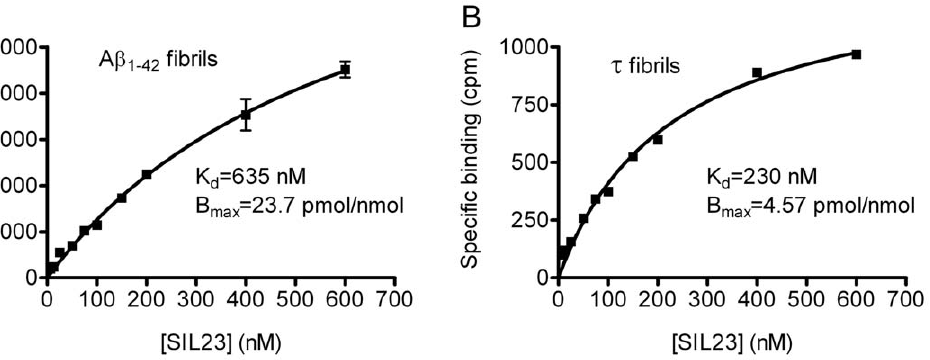
Figure 4. Radioligand binding studies demonstrate that [ 125 I]SIL23 has selectivity for binding recombinant a -syn fibrils compared to synthetic A b 1–42 fibrils or recombinant tau fibrils. Binding affinities of [ 125 I]SIL23 to A b ( A ) and tau ( B ) fibrils were determined in saturation binding studies. The determined K d values of A b and tau fibrils were 635 nM and 230 nM, respectively. Data points represent mean + / 2 s.d. (n=3). Similar results were obtained in more than three independent experiments for saturation binding